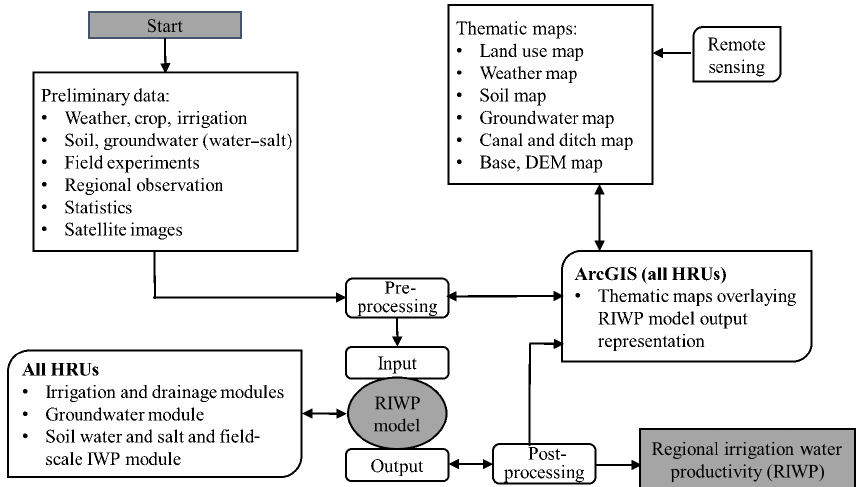
Figure 4. Procedure chart for the regional irrigation water productivity